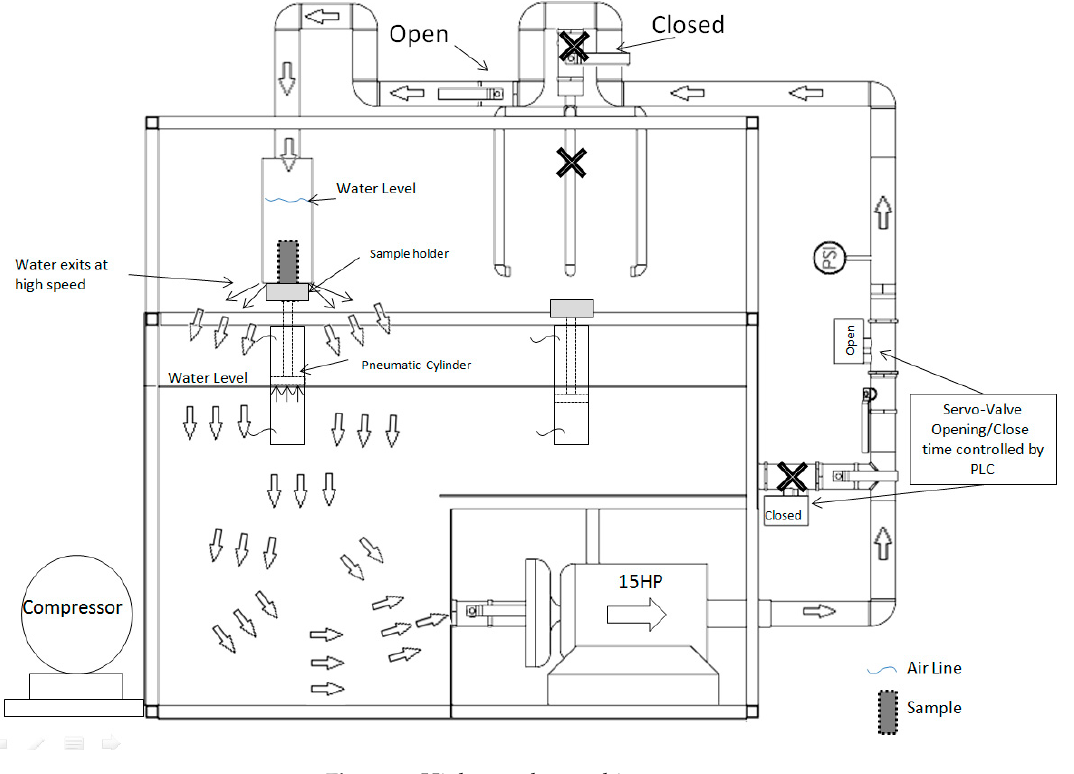
Figure 1. High-speed quenching system.